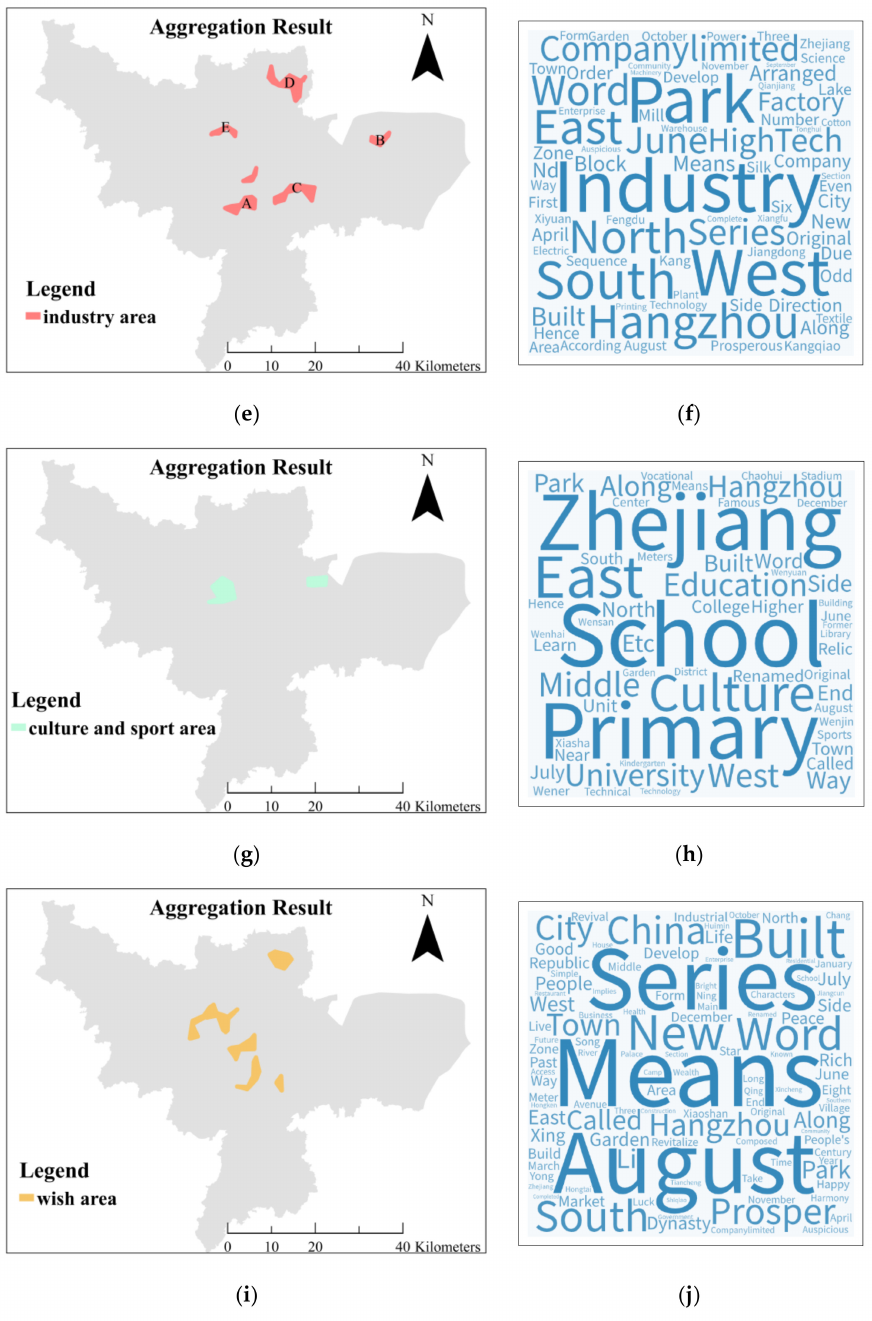
Figure 11. Spatial aggregation results of featured functional areas and the corresponding cloud of words. ( a , b ) correspond to administrative area; ( c , d ) correspond to scenic area; ( e , f ) correspond to industry area; ( g , h ) correspond to culture and sport area; ( i , j ) correspond to wish area. A-E in ( e ) are the extracted main industrial parks, namely Binjiang industrial zone, Dajiangdong industrial zone, Xiaoshan economic and technological development zone, Yuhang industrial zone, and Xiangfu industrial